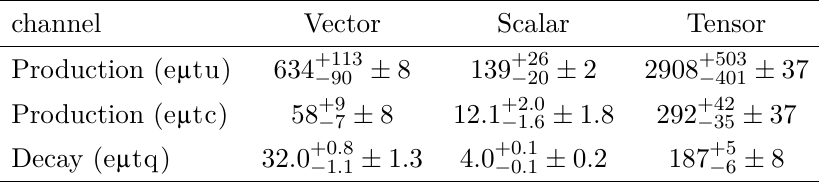
Table 1 . Theoretical cross sections, in fb, for single top quark production and top quark decays via the vector, scalar, and tensor CLFV interactions, assuming a top quark mass of 172.5 GeV, the top quark decay width 1.33 GeV, Λ = 1 TeV and C e m tq = 1 . The uncertainties from the QCD scales x and PDF are given ( σ + scale ± − scale